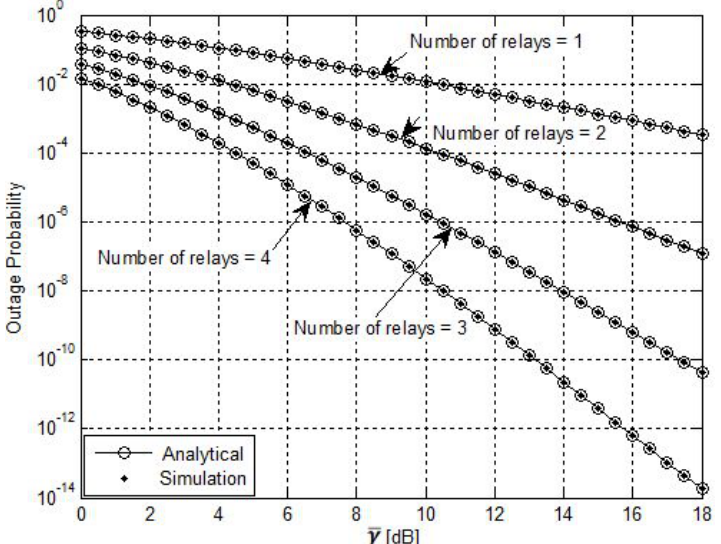
Figure 2. Impact of number of relays on the system performance, ( m sp = m kp = 1, m sk = m kd = 2 and the PU was at (0.6,